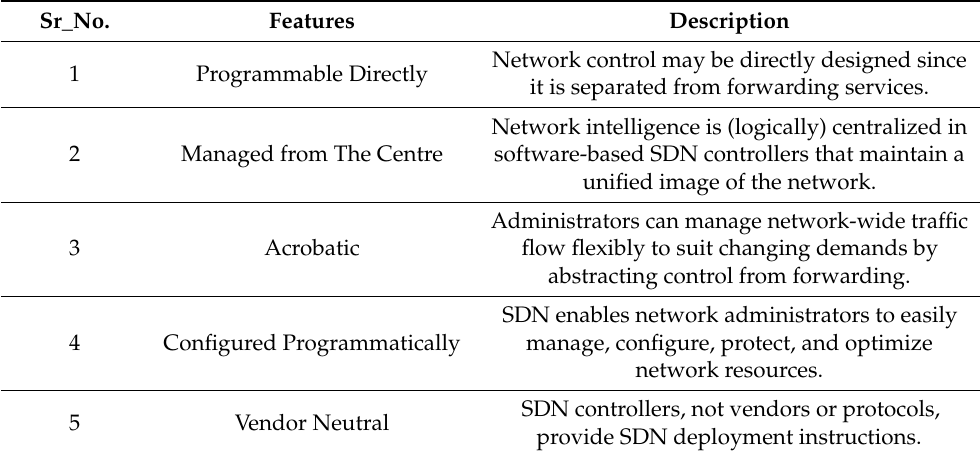
Table 1. SDN architecture [5]